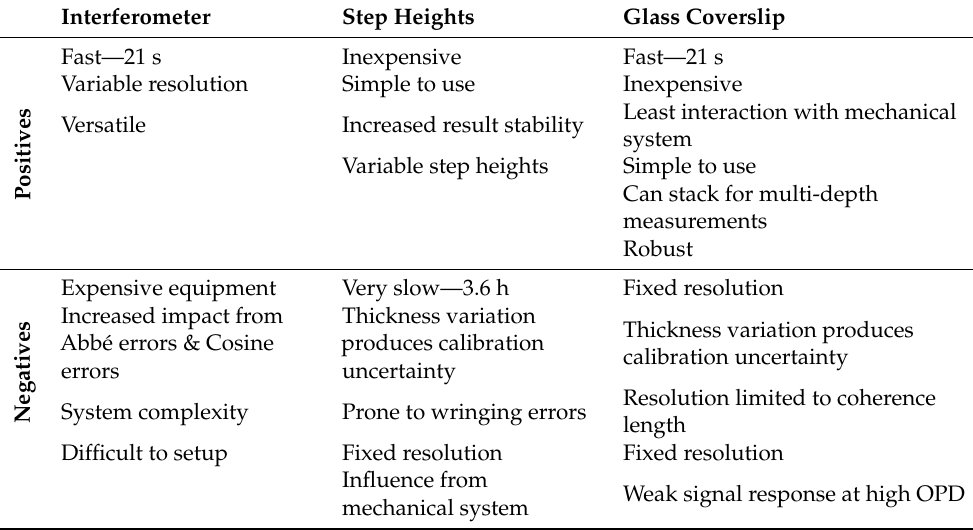
Table 2. Advantages and disadvantages of each calibration approach